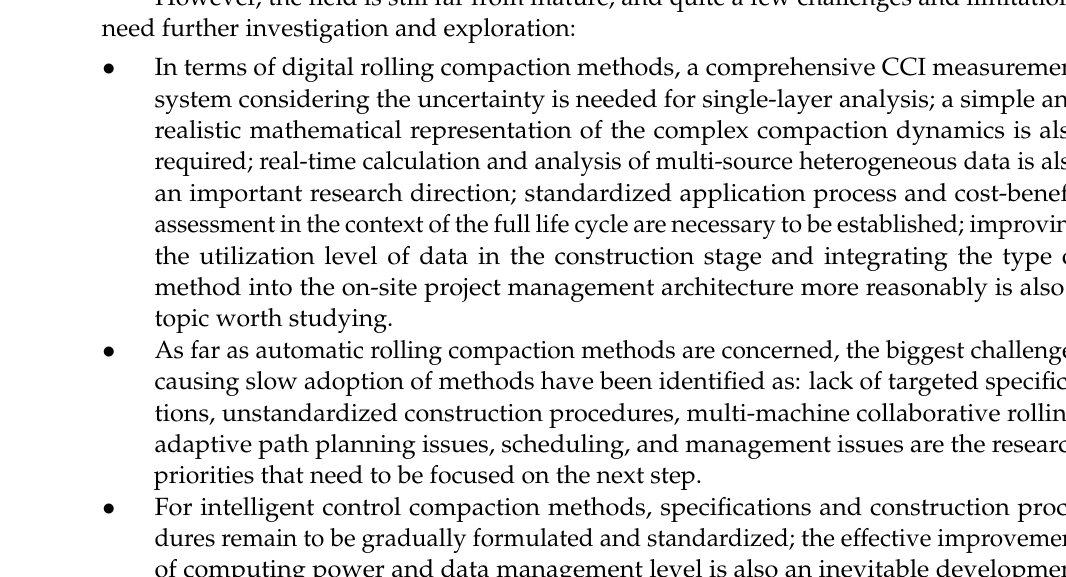
Table 6. Comparison of advantages of different QC/QA methods (